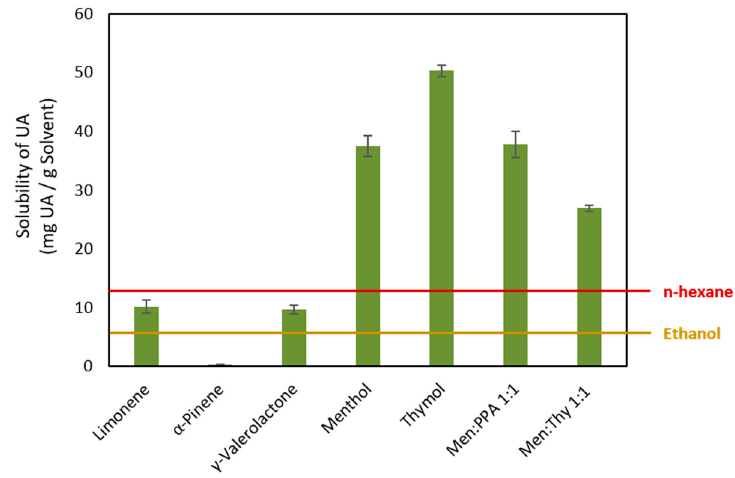
Figure 3. Solubility of ursolic acid (UA) in different solvents: limonene, α -pinene, γ -valerolactone, menthol, thymol, menthol:phenyl propionic acid (PPA) (Men:PPA), menthol:thymol (Men:Thy) at 60 ◦ C; comparison with some volatile organic solvents: n-hexane and ethanol.